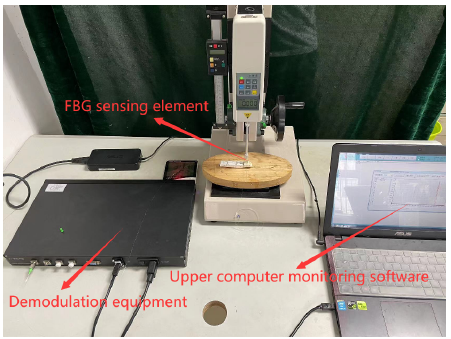
Figure 14. Sliding detection experimental